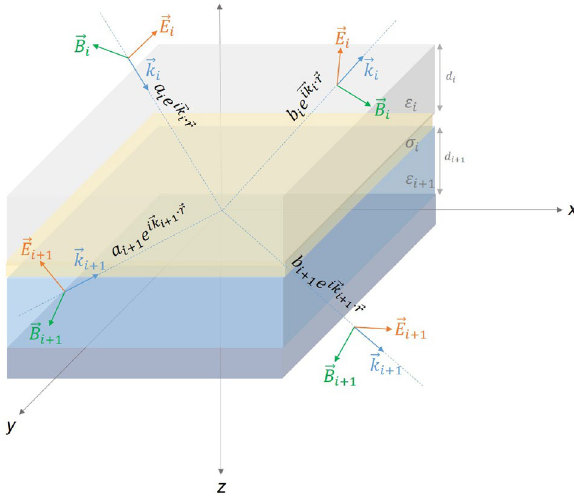
Figure 8. A structure consisting of dielectric layers with different ε i